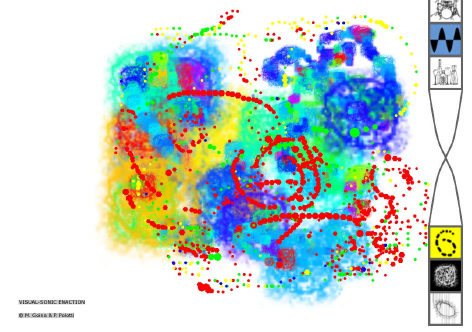
Figure 11. The final image of a visual-sonic self- portrait. On the right side, the icons represent the sound groups (top) and the graphics families